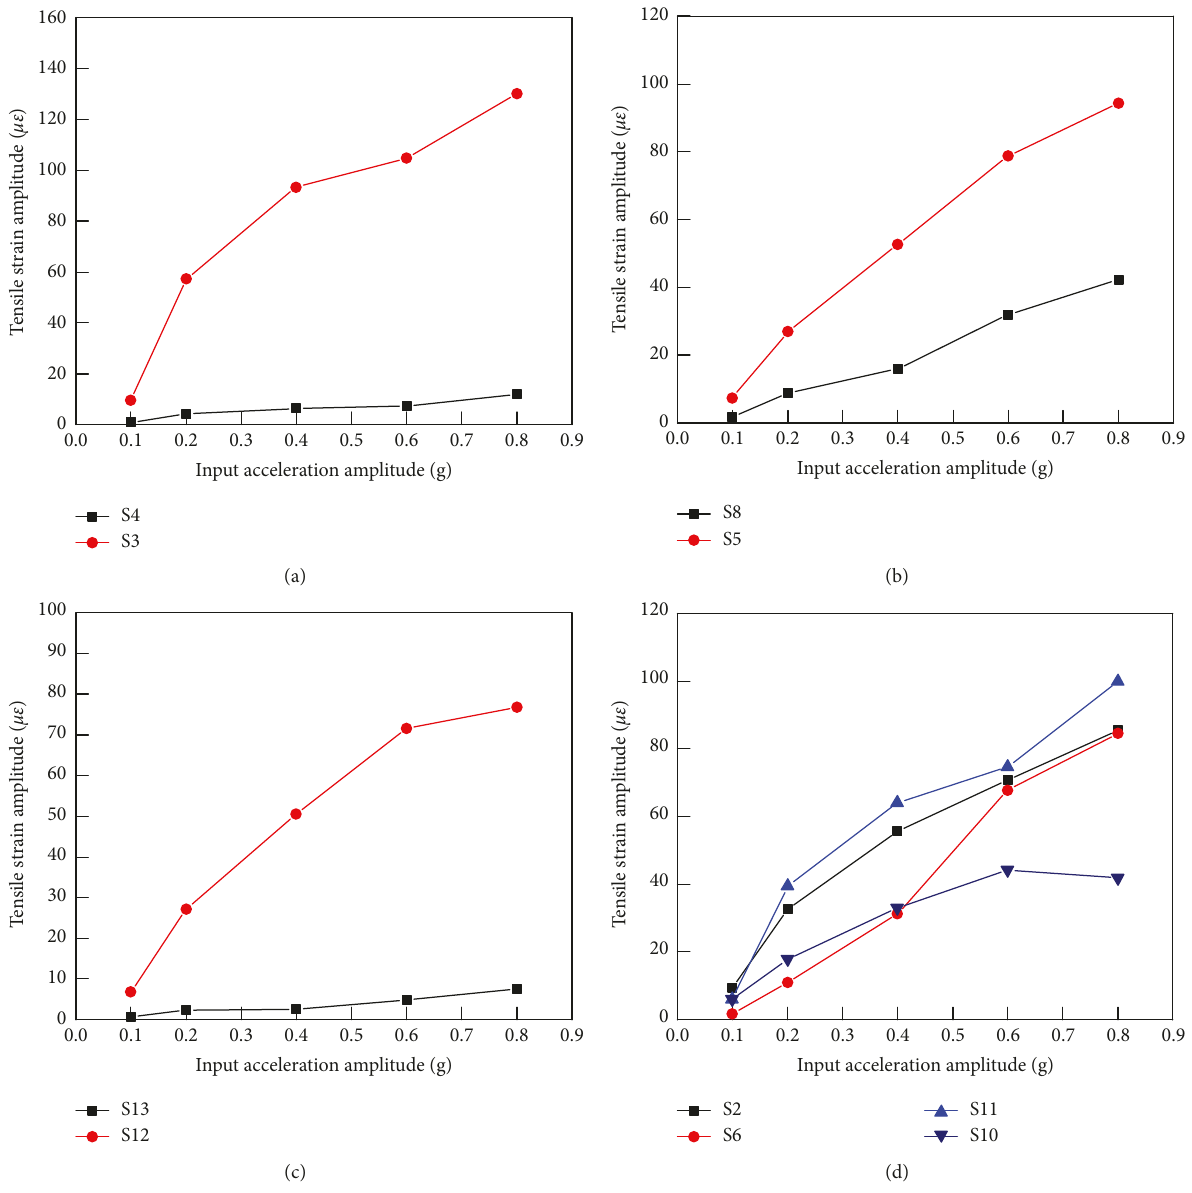
Figure 18: Tensile strain amplitude of the subway station structure under the Kobe ground motion. (a) Roof slab. (b) Middle slab. (c) Bottom slab. (d) Lateral